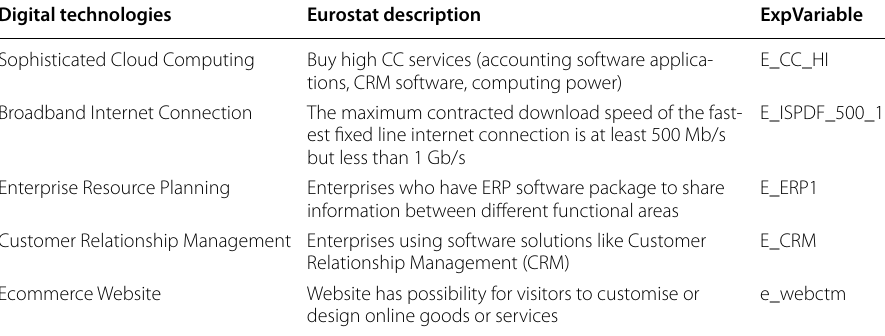
Table 1 Description of variables Digital